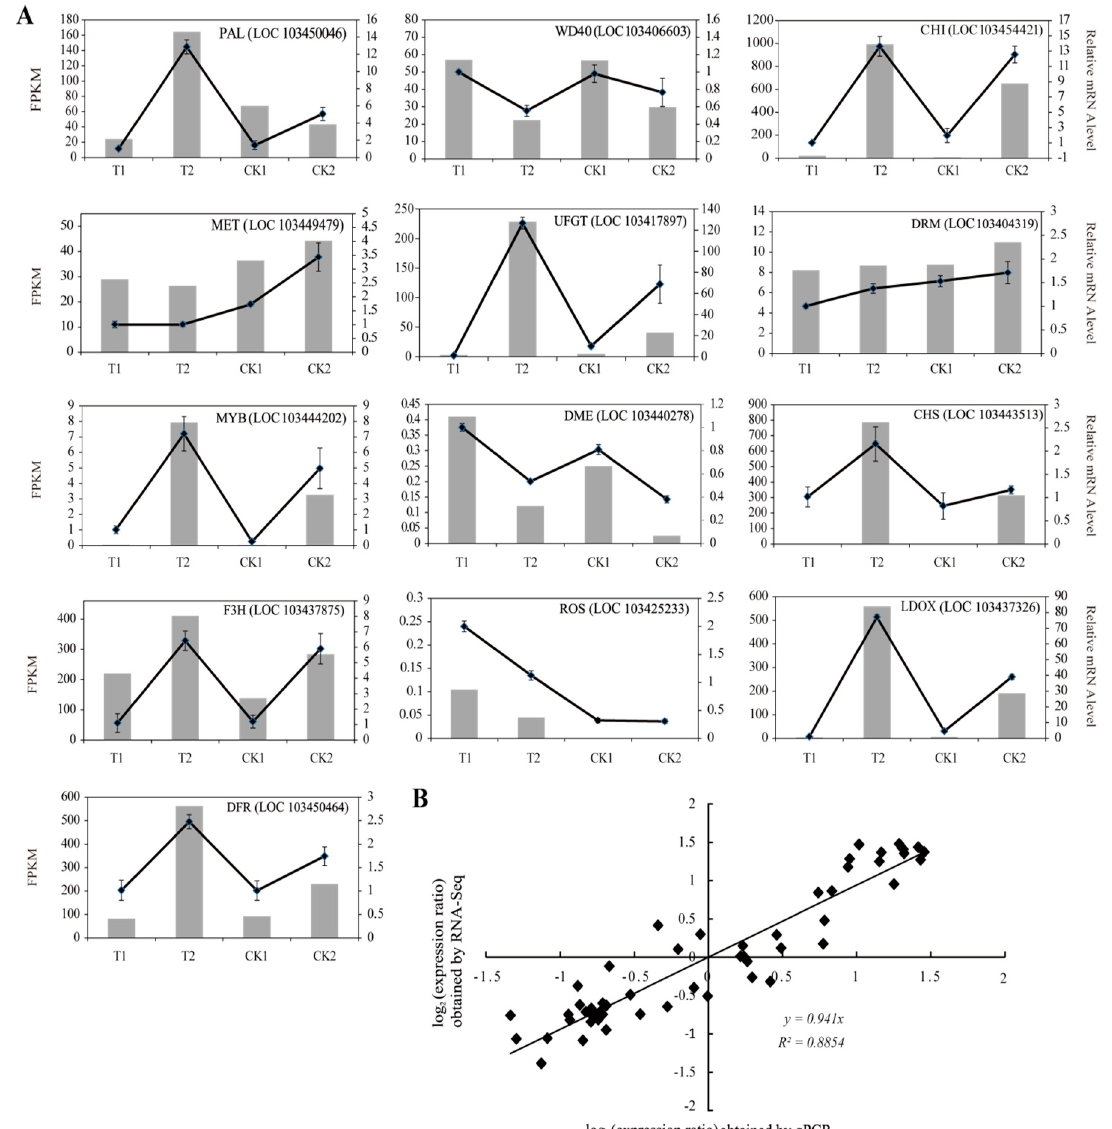
Figure 7. Quantitative real-time PCR (qRT-PCR) analysis of DEGs in “Granny Smith” apple skins. ( A ) Transcript levels and qRT-PCR results of 13 selected genes identified in RNA-sequencing. The left y -axis indicates the corresponding expression data from RNA-seq (gray histogram). The right y -axis shows the relative gene expression level measured by qRT-PCR (black lines). The x -axis represents the time (days) after 5-aza-dC treatment. Bars represent standard error (SE; n = 4). ( B ) Comparison between the log 2 values of gene expression ratios obtained from RNA-seq and qRT-PCR methods.